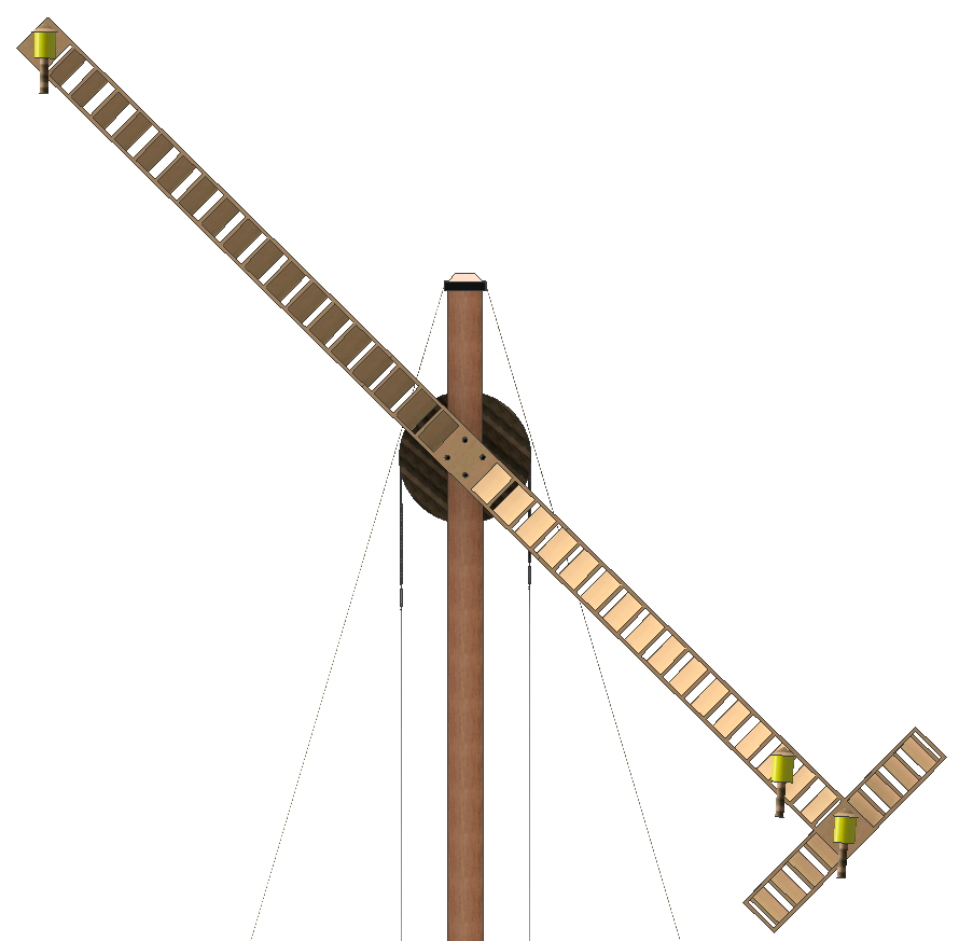
Figure 21. Detail of the placement of the indicator arrow on the mast.